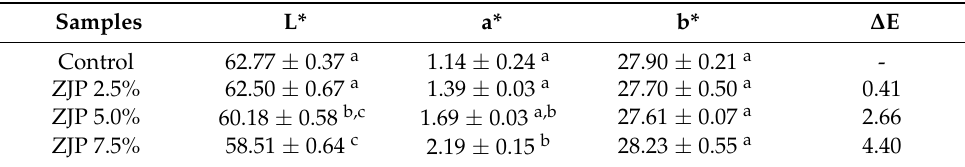
Table 4. Color values of pizza base